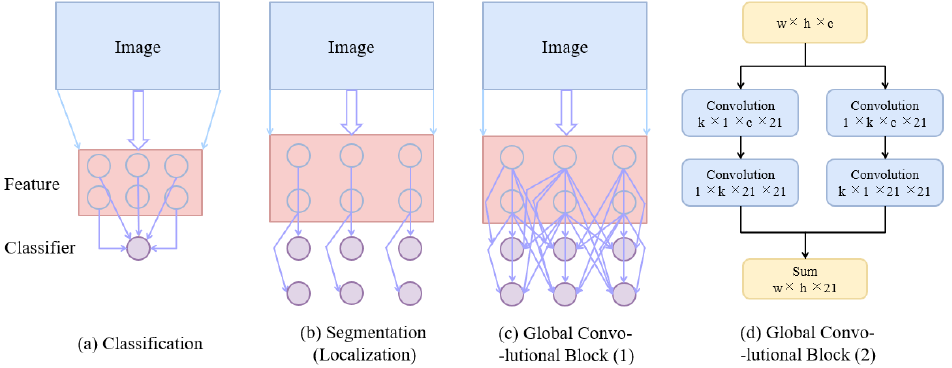
Figure 5. ( a ): Classification network; ( b ): Conventional segmentation network, mainly designed for localization; ( c ): Global Convolutional Block; ( d ): The structure of Global Convolutional Block.